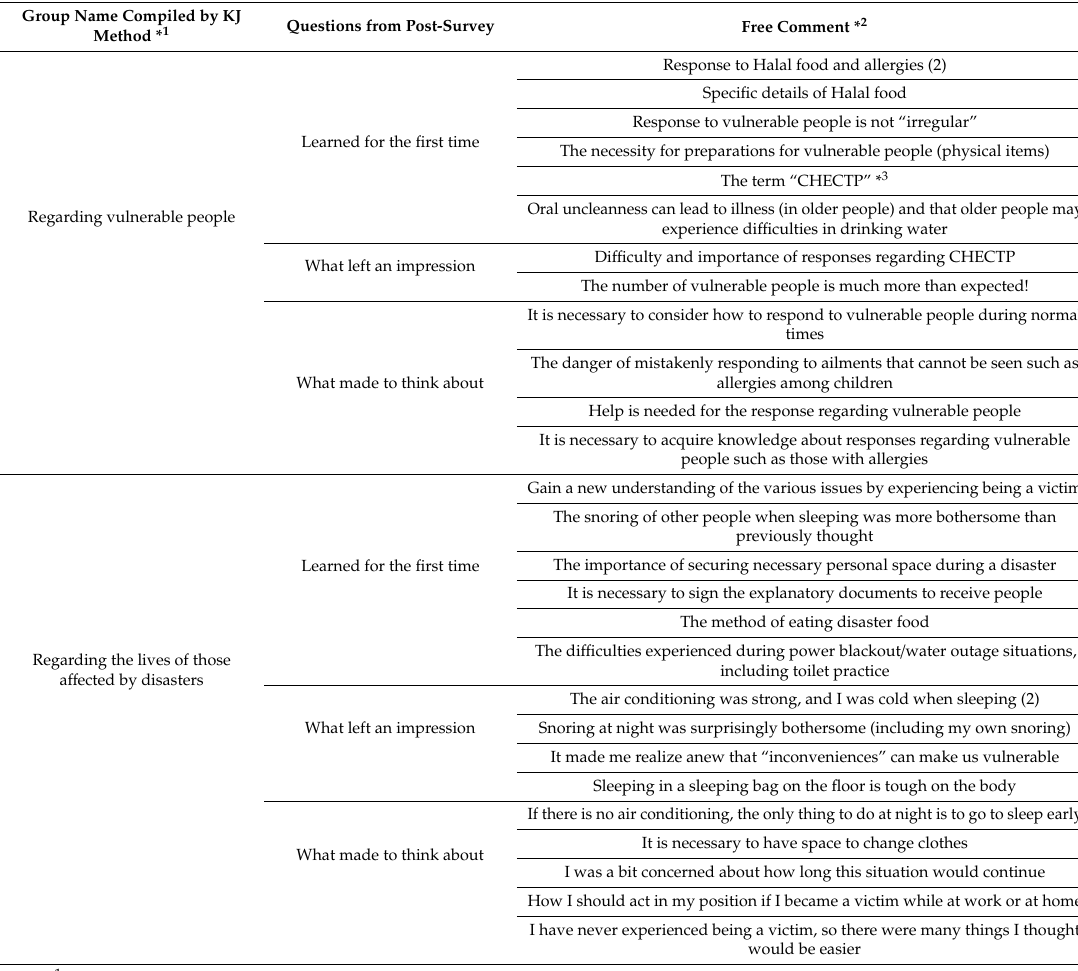
Table 6. Answers regarding vulnerable people and those whose lives are a ff ected by a disaster after taking this course from among “Learned for the first time”, “What left an impression”, and “What made to think about” (n =